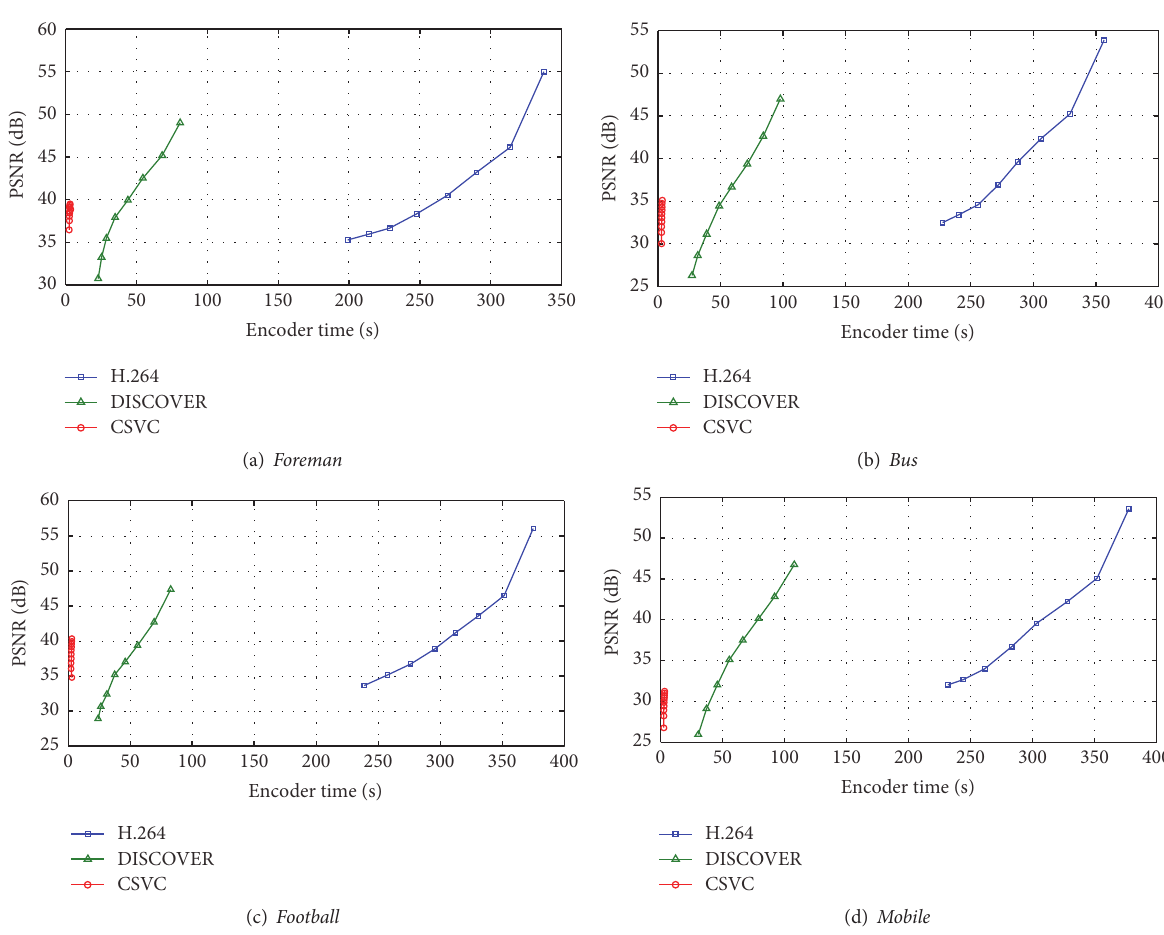
Figure6:Comparisonofrate-energy-distortionperformanceofH.264,DISCOVER,andCSVCencoderunderdifferenttestvideosequences.